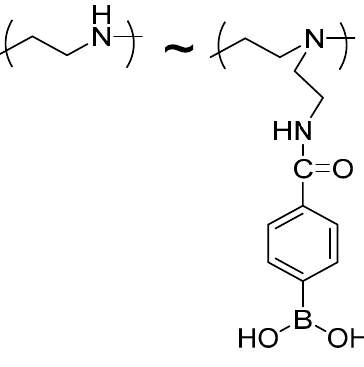
Figure 2. Chemical structure of PBA-PEI.